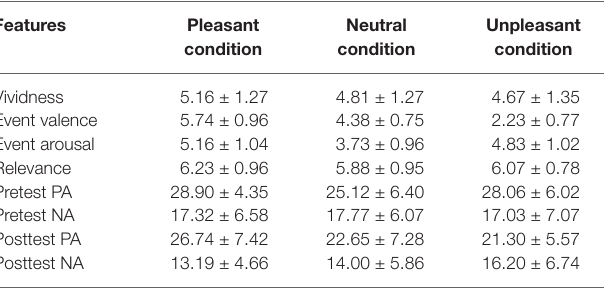
TABLE 2 | Results of episodic thinking (ET) in different conditions ( M ± SD ). Features Pleasant condition